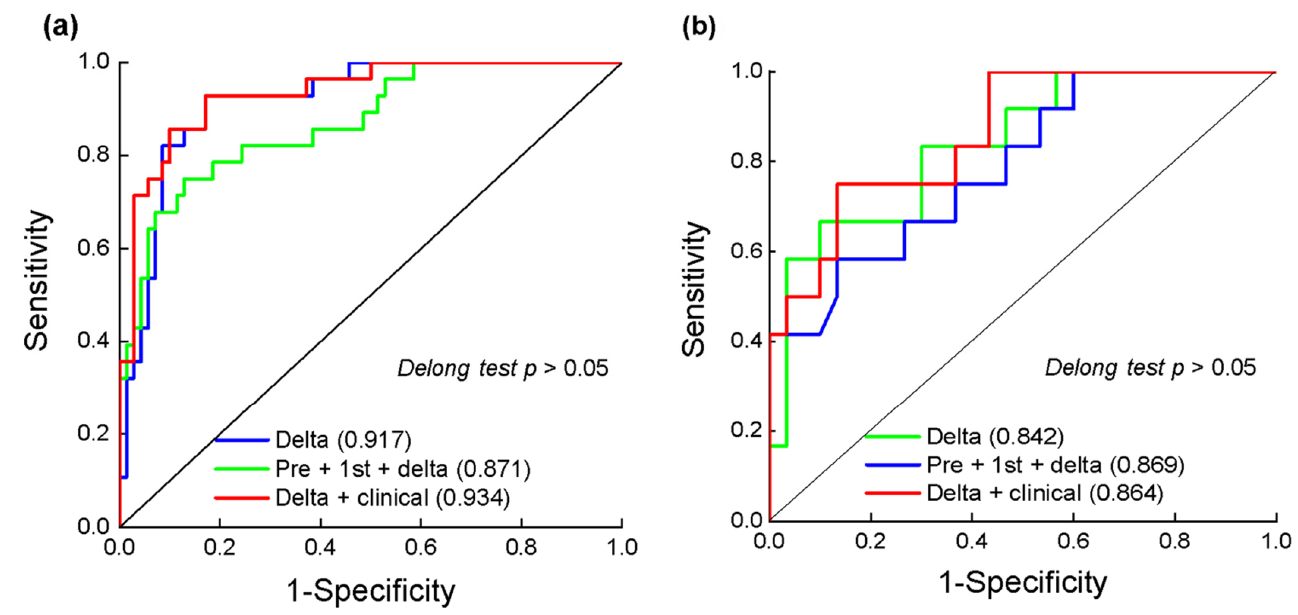
Figure 6. Receiver operating characteristic (ROC) curves of the delta-radiomics model, the longitudinal fusion radiomic model, the clinical-radiomics model in training cohort ( a ) and validation cohort ( b ) based on CEe. Numbers in parentheses are areas under the receiver operating characteristic curve (AUC).